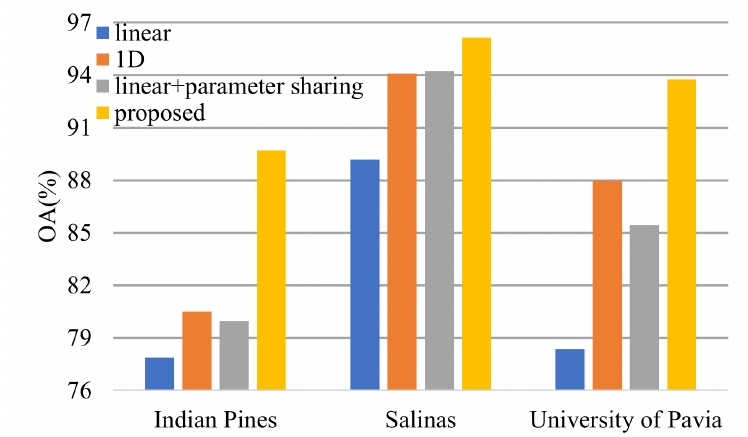
Figure 18. Effectiveness of the 1-D convolution and parameter